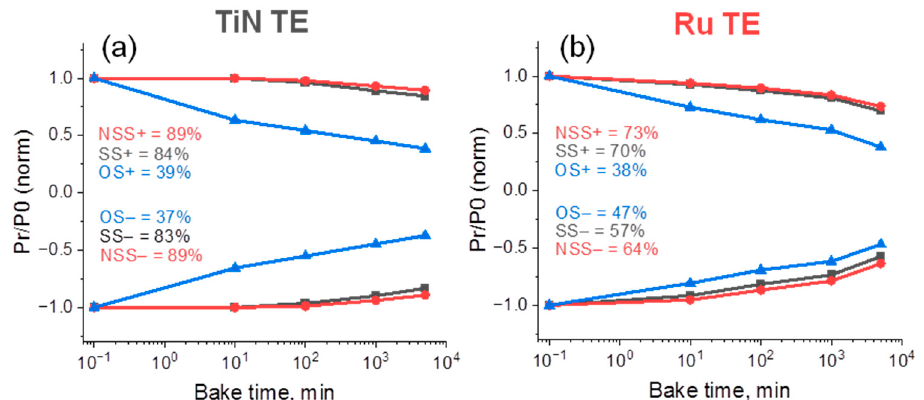
Figure 5. Retention at 85 °C of SS, NSS and OS states for the upward P ↑ (SS + , NSS + and OS − ) and downward P ↓ (SS − , NSS − and OS + ) polarization states each versus bake time for HZO-based capacitors with TiN ( a ) and Ru ( b ) TE. Measurements were performed using trapezoidal voltage pulses with a duration of 3 μ s (1 μ s rise and 1 μ s fall times) and amplitude of 3V.